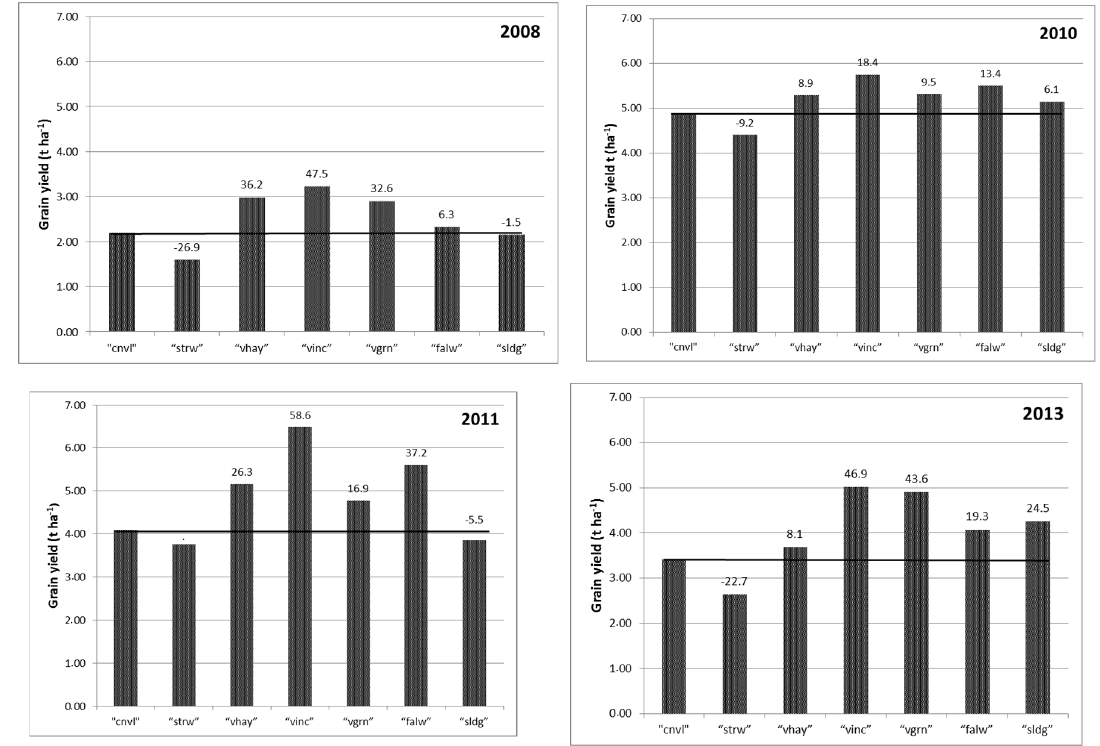
Figure 1. Average grain yield production in t ha − 1 obtained at the “test years” of the four rotation cycles. Numbers above the columns indicate yield surpluses, i.e., the percentage difference of this production in relation to the “cnvl”.